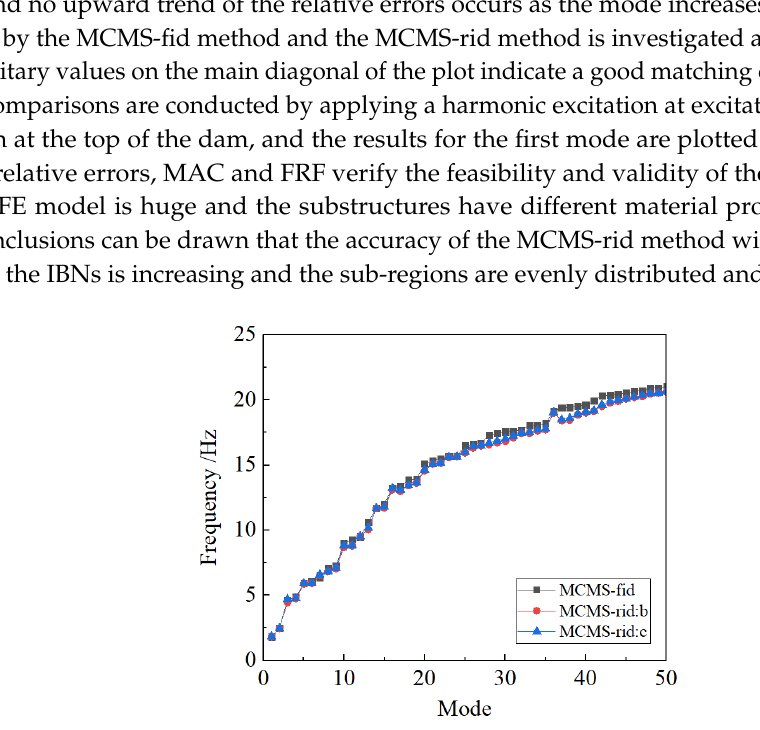
Figure 14. The first fifty natural frequencies (Hz) by the MCMS-fid and MCMS-rid methods.